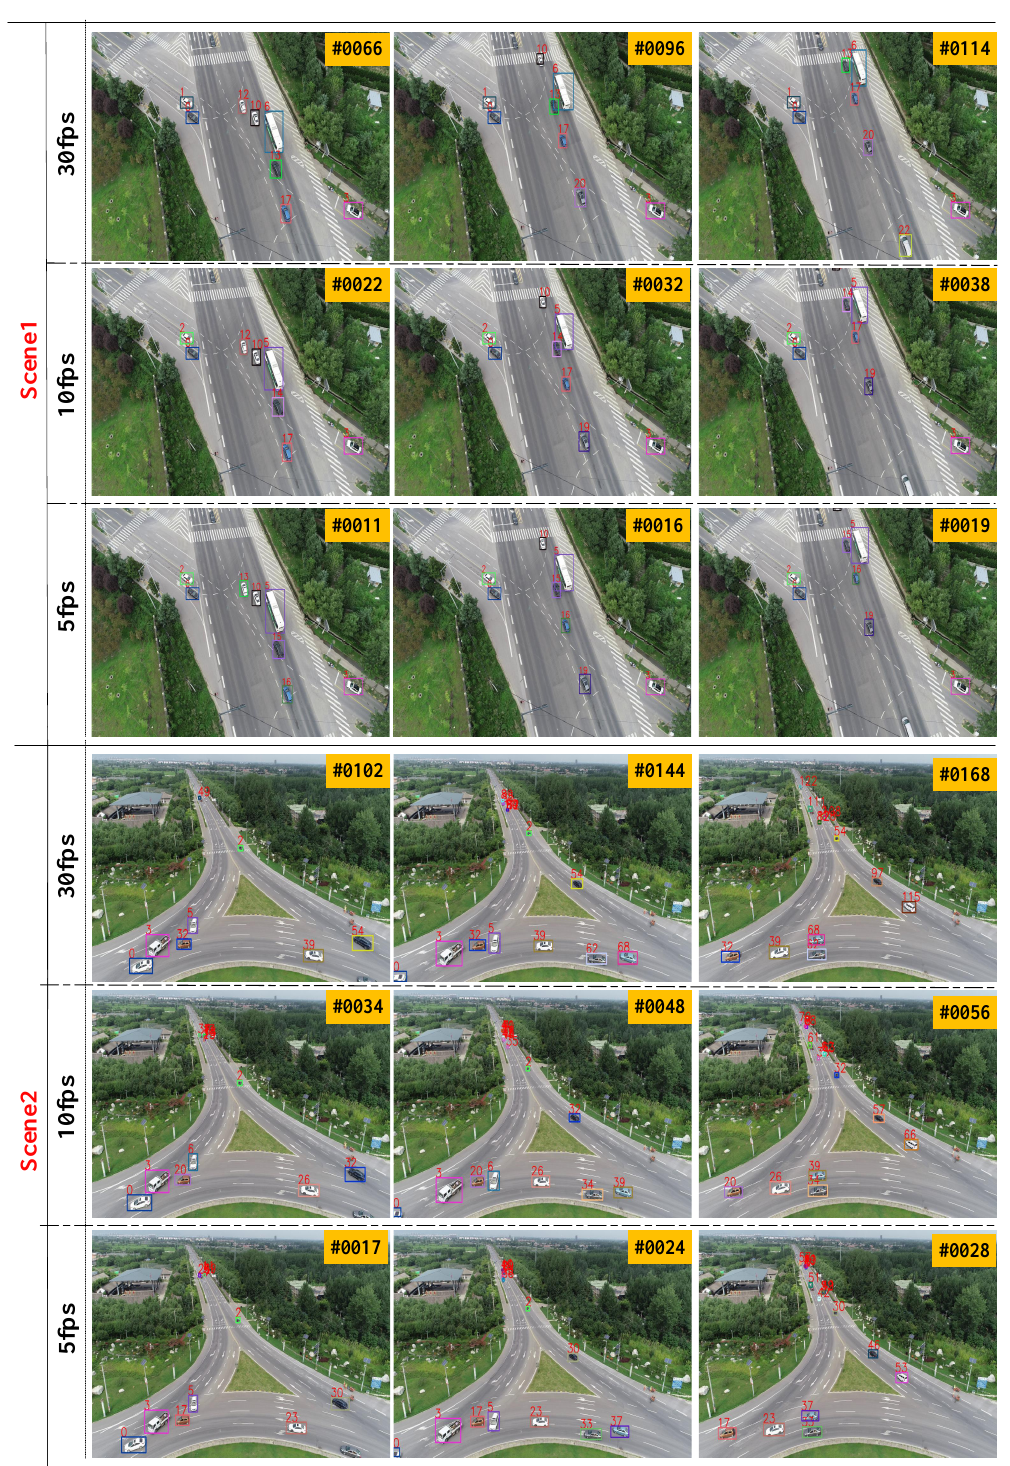
see that the test dataset included four scenes, and each scenario included three different frame rates. The experiment results on this dataset are shown in Figures 6 and 8.